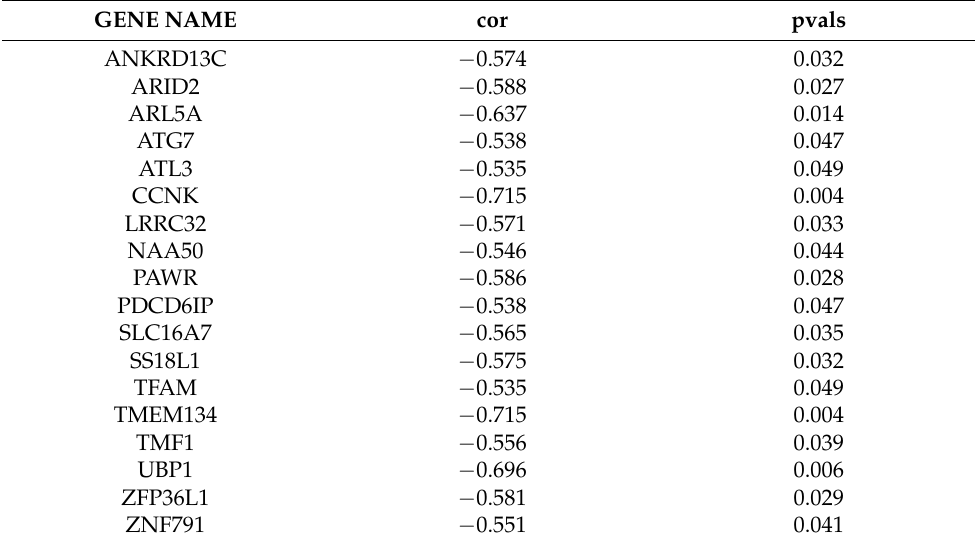
Table 4. Correlation of miR181a and b expression and target genes in melanoma